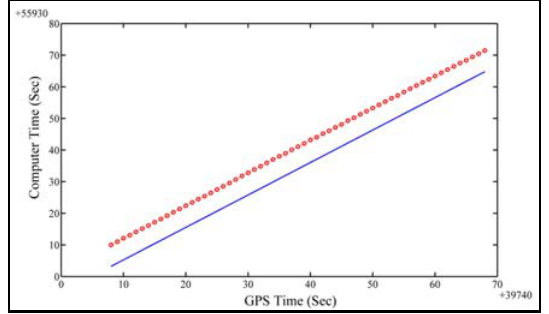
Figure 6. Comparison of GPS and computer time